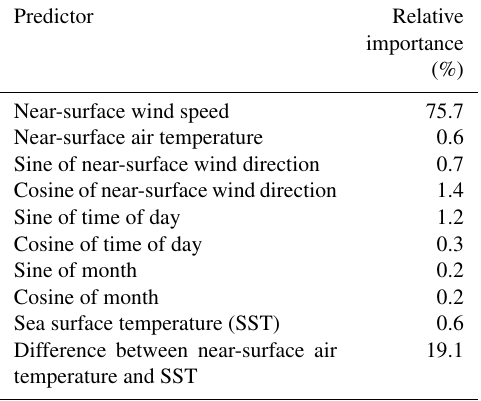
Table 7. Predictor importance for the random forest used to extrap- olate winds at 140ma . s . l . at lidar Atlantic Shores 06.